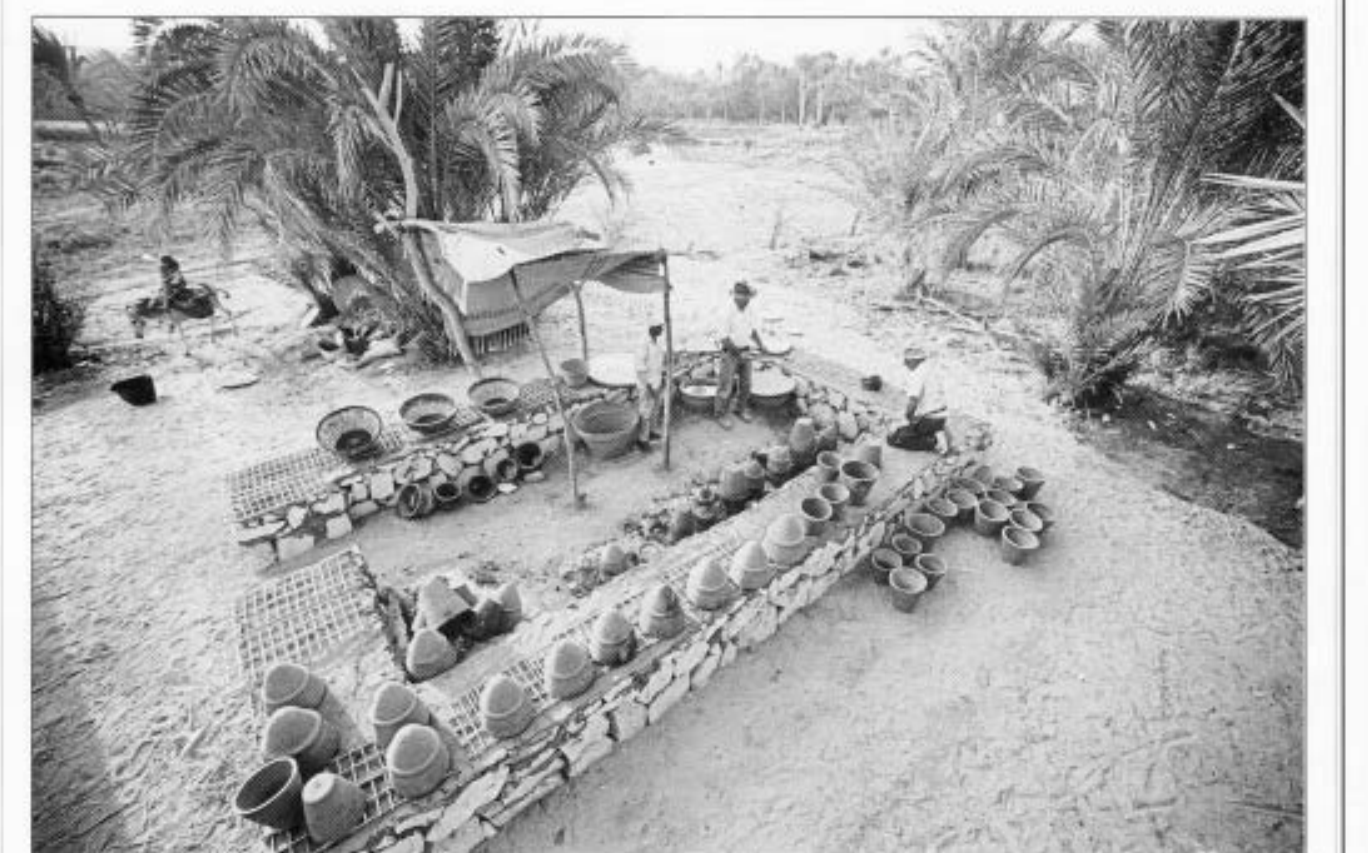
Figure 6 Experimental reconstruction of a bakery at Giza, with all the elements found in ancient bakeries at